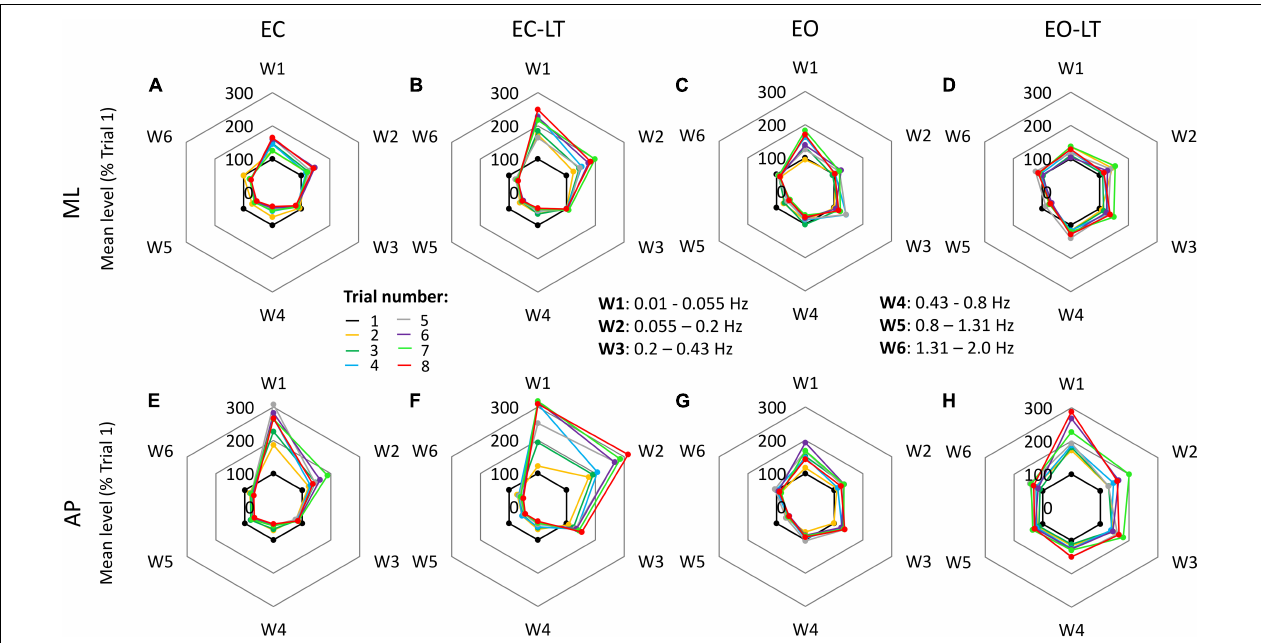
FIGURE 5 | Changes in the mean level of the power spectrum in the six frequency windows, in which the full spectrum (from 0.01 to 2.0 Hz) was separated, for all trials and sensory conditions. Data are expressed as a percent of the spectrum mean level of the first trial (black dots at 100%) in each condition and direction (this prevents a quick comparison of the graphs between conditions). In general, for both ML (A–D) and AP (E–H) directions and for all sensory conditions, the mean level of the spectrum increased over the successive trials in the first two windows (W1 and W2), showed minor changes in W3, and decreased in the windows from W4 to